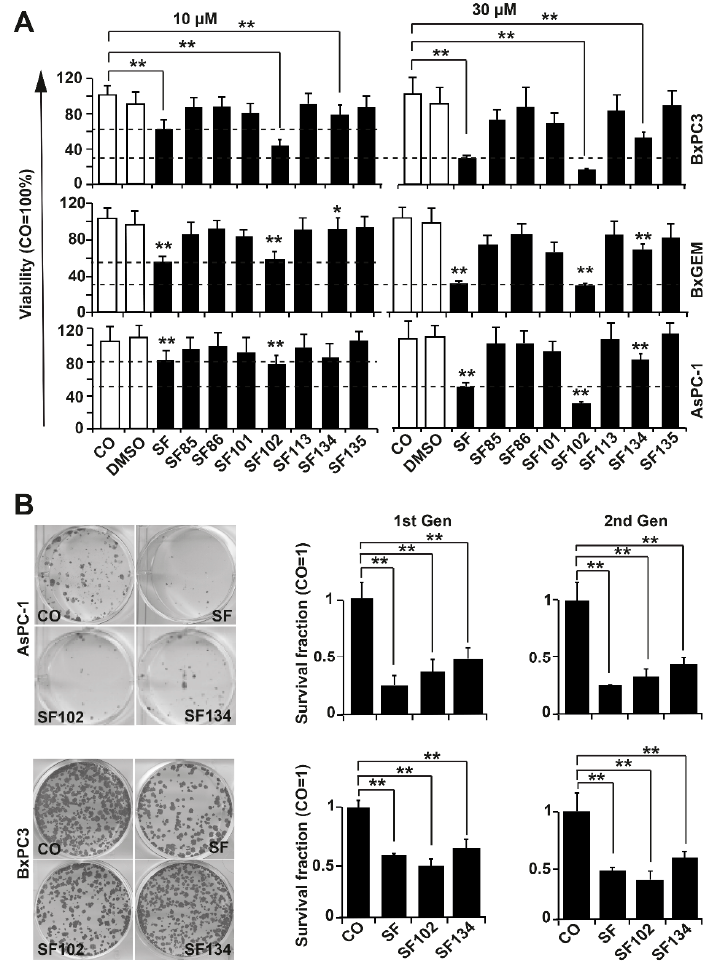
Figure 2. SF102 and SF134 repress viability and colony formation. (A) BxPc-3, BxGEM, and AsPC-1 cells were treated with sulforaphane (SF , 10 µM or 30 µM) and its analogues SF85, SF86, SF101, SF102, SF113, SF134 , and SF135 , or were left untreated (CO). After 24 h, the viability was measured by 3-(4,5-dimethylthiazol-2-yl)-2,5-diphenyltetrazolium bromide (MTT) assay. DMSO was used as a vehicle control. Data are means ±SD of at least three independent experiments. (B) BxPc-3 and AsPC-1 cells were treated with sulforaphane, SF102 or SF134 as described above, followed by plating of viable cells 24 h later at a low density (BxPc-3: 500 cells/well, AsPC-1: 1000 cells/well) in 6-well plates. After two weeks, colonies were fixed with 4% paraformaldehyde (PFA) and Coomassie-stained. Colonies containing more than 50 cells were quantified under a dissecting microscope and photographed. Representative images are shown on the right. The percentage of plating efficiency was calculated by setting the number of surviving colonies in the control group to 1. The diagrams on the left show the survival fraction (1st Gen). The surviving cells were harvested from non-fixed and non-Coomassie-stained duplicate plates of the first generation (1st Gen) of colony formation, and re-plated at the same density in 6-well plates. Two weeks later, the clonogenic survival of the second generation (2nd Gen) was evaluated as described above. The means ± SD are shown. ** p < 0.01, * p < 0.05. To study the ability to interfere with clonogenicity, which is a typical tumor stem cell feature, BxPc-3 and AsPC-1 cells were treated with sulforaphane, SF102 or SF134 . After 24 h, a